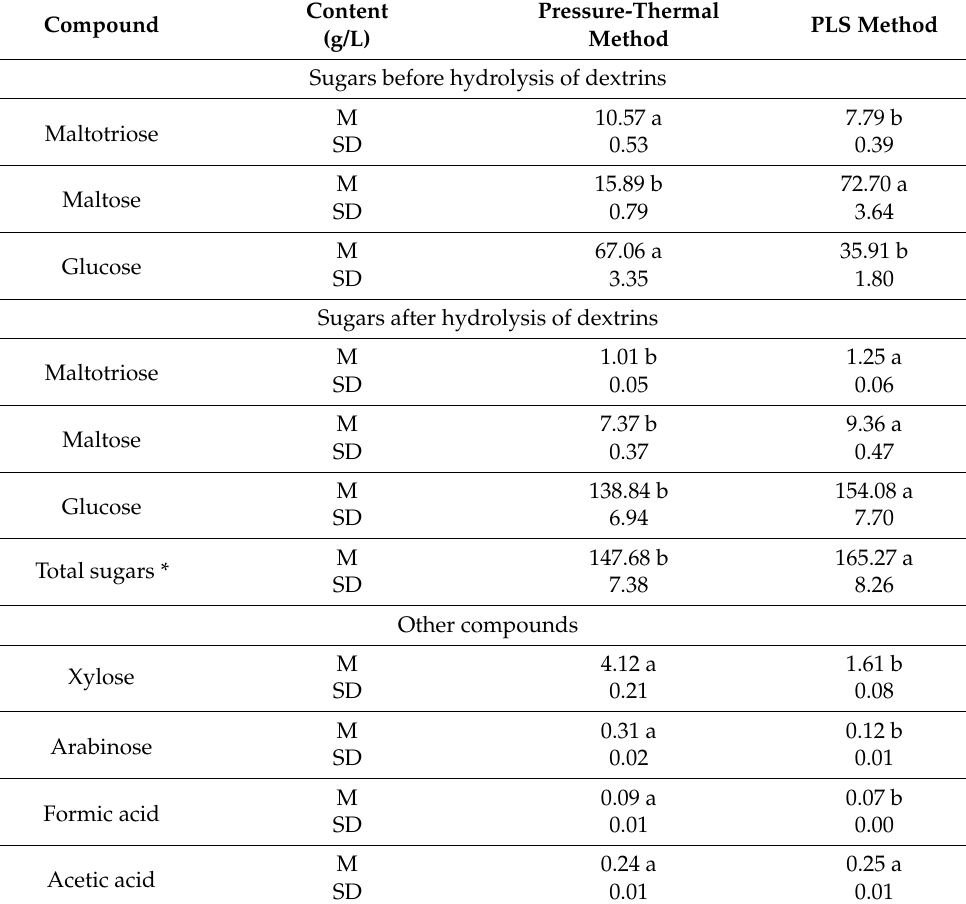
Table 1. Chemical composition of sweet mashes obtained by the pressure-thermal method and pressureless (PLS)